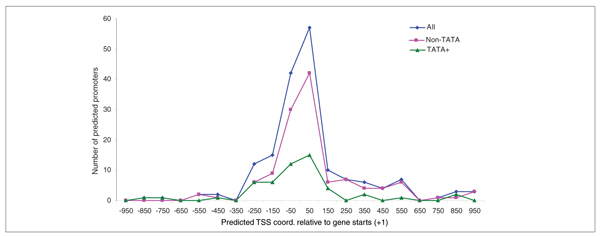
A distribution of predicted TSS relative to the start of mRNA sequences. Figures on the x-axis are centers of 100 bp intervals, for example, mark 50 corresponds to [+1,+100] interval.